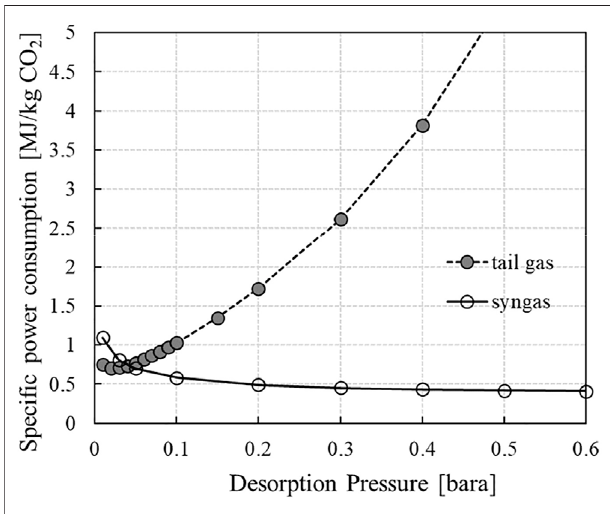
FIGURE 7 | Effect of desorption pressure on speci fi c power consumption.